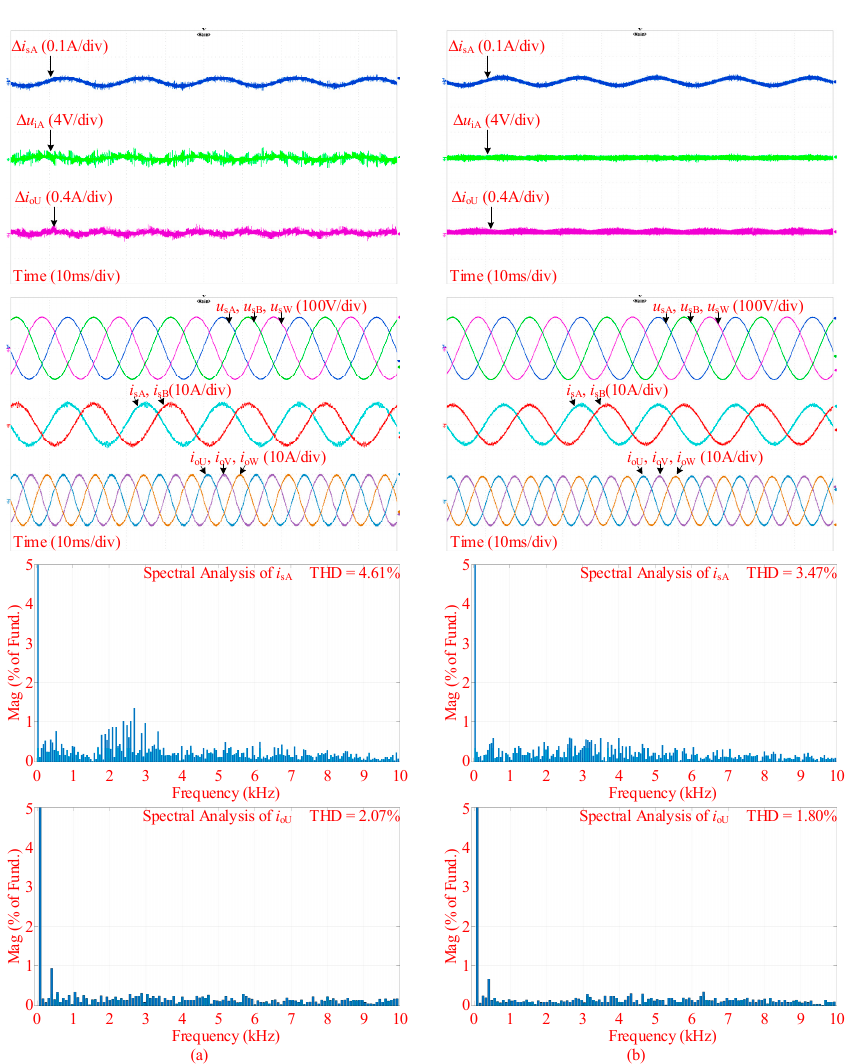
Figure 6. Experimental results of Case 1: ( a ) with the conventional MPC and ( b ) with the improved MPC. Experimental conditions are normal.